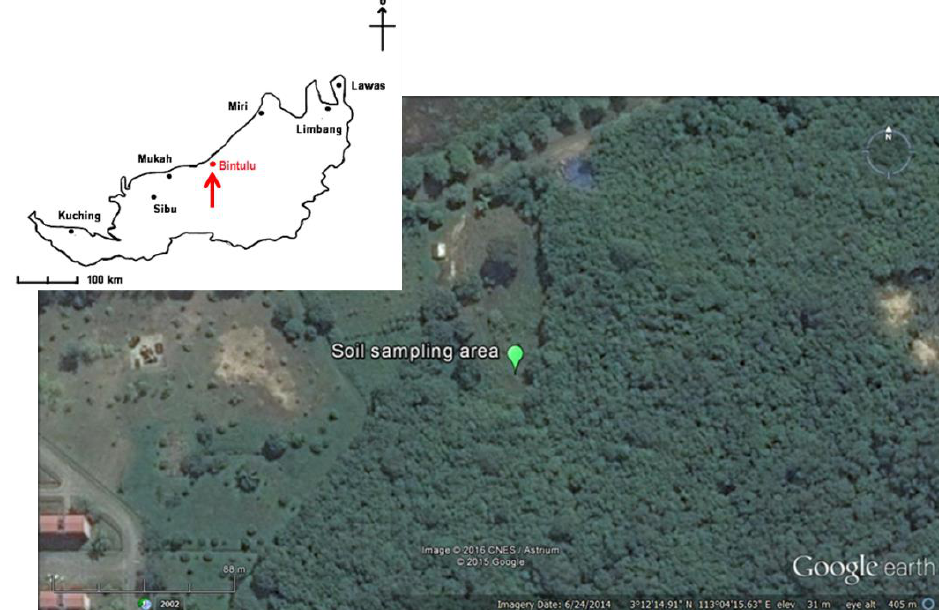
Figure 1. Aerial view showing where the soil used for the sorption studies was taken.